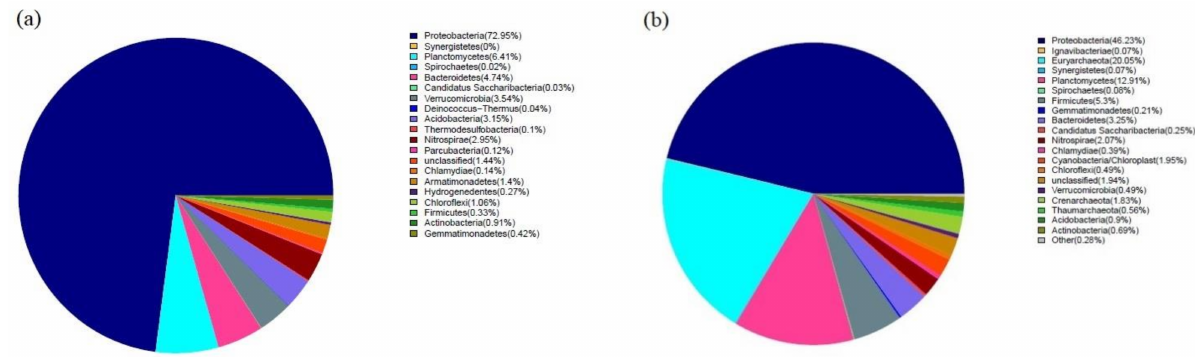
Figure 6. Distribution of bacteria in biofilm. ( a ) Before shock disinfection. ( b ) After 60 min of shock